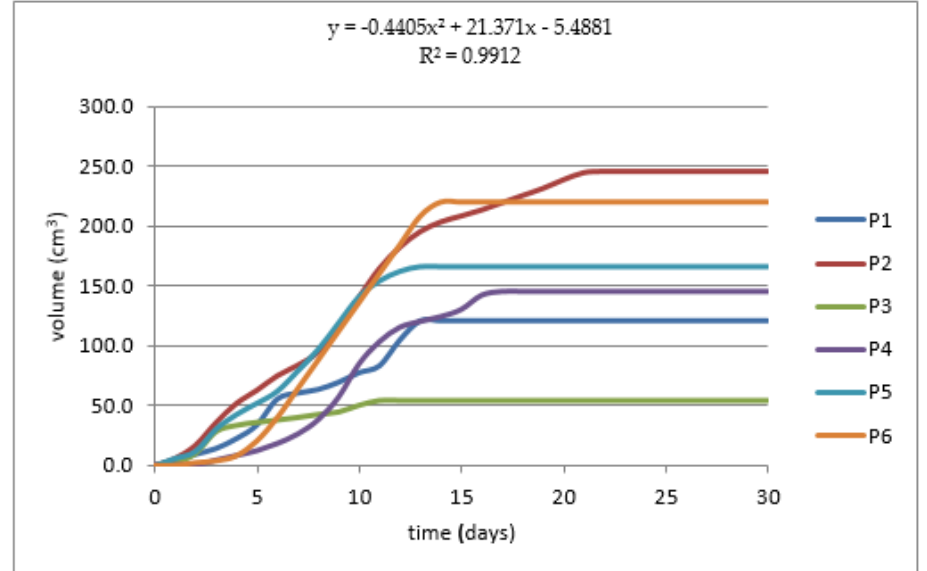
Figure 4. Accumulated average daily production [11].